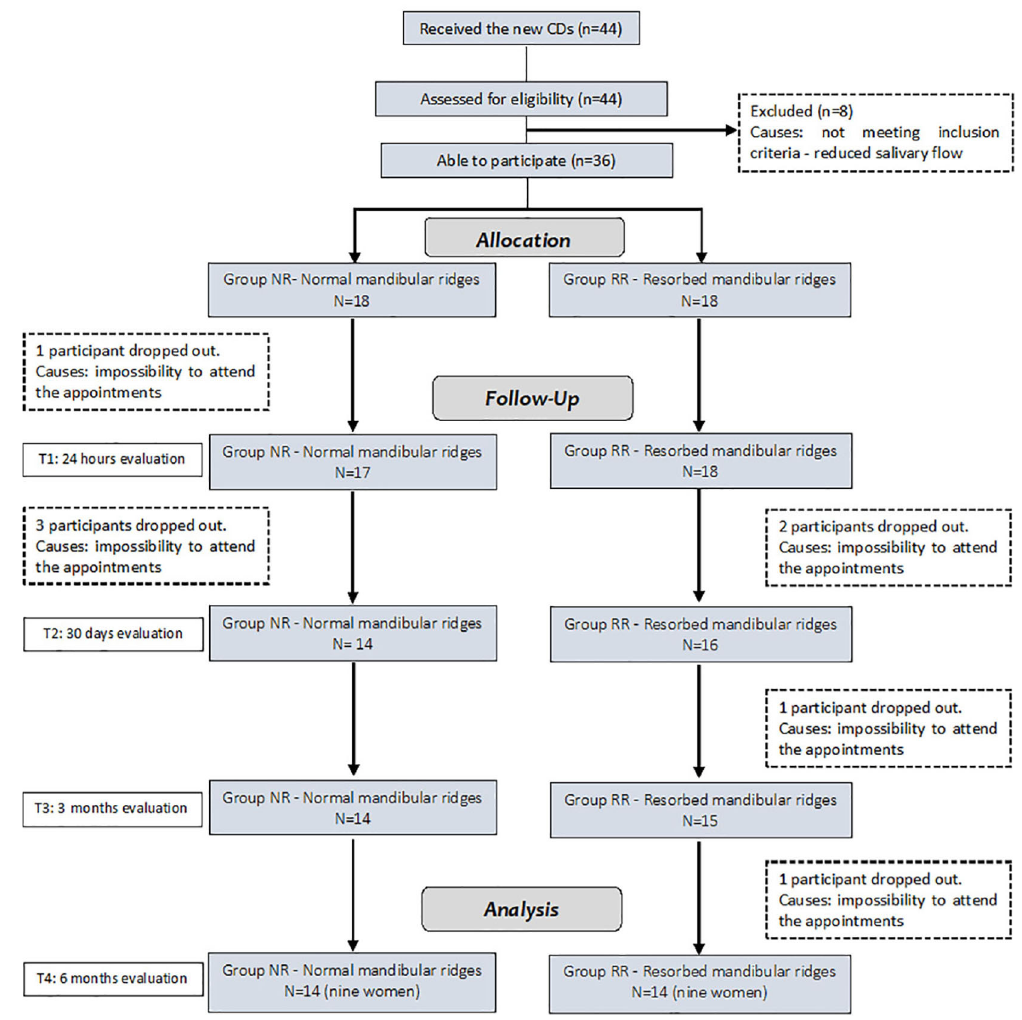
Figure 1- Flowchart of